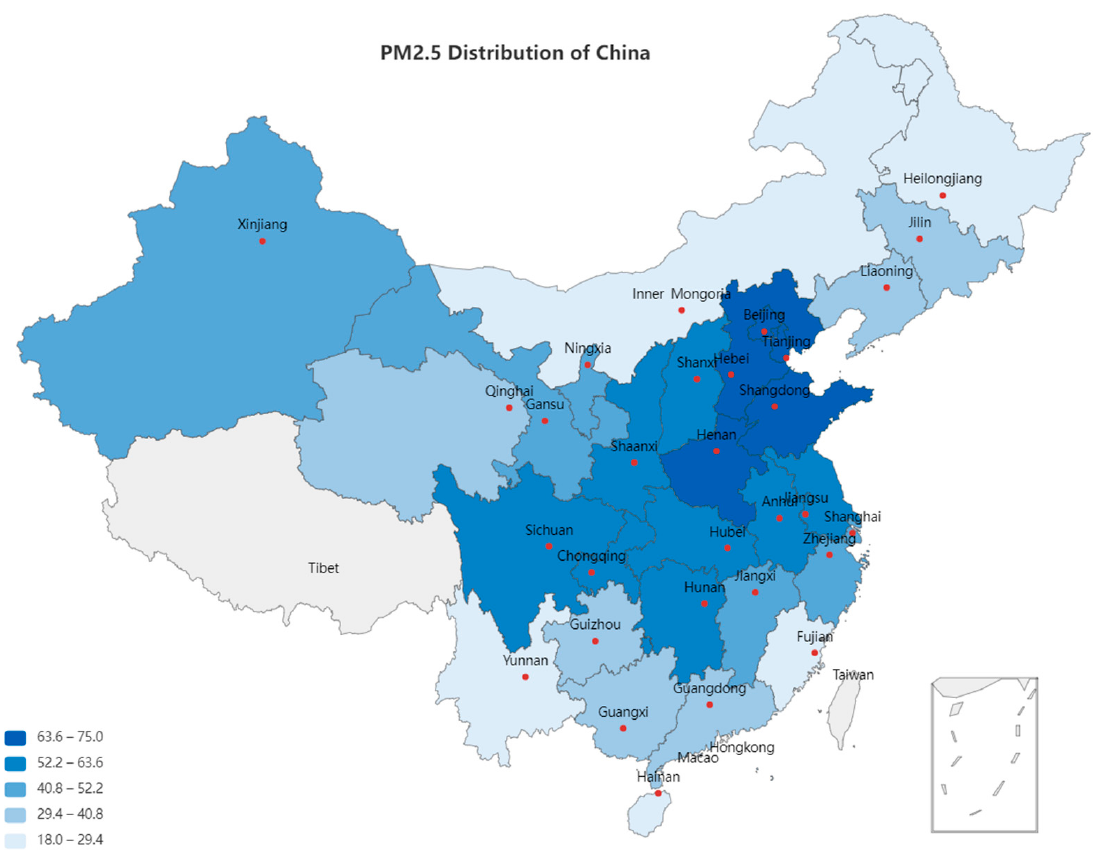
Figure 1. Distribution of mean PM 2.5 of each province. Note: Data source is the Atmospheric Composition Analysis Group of Washington University.